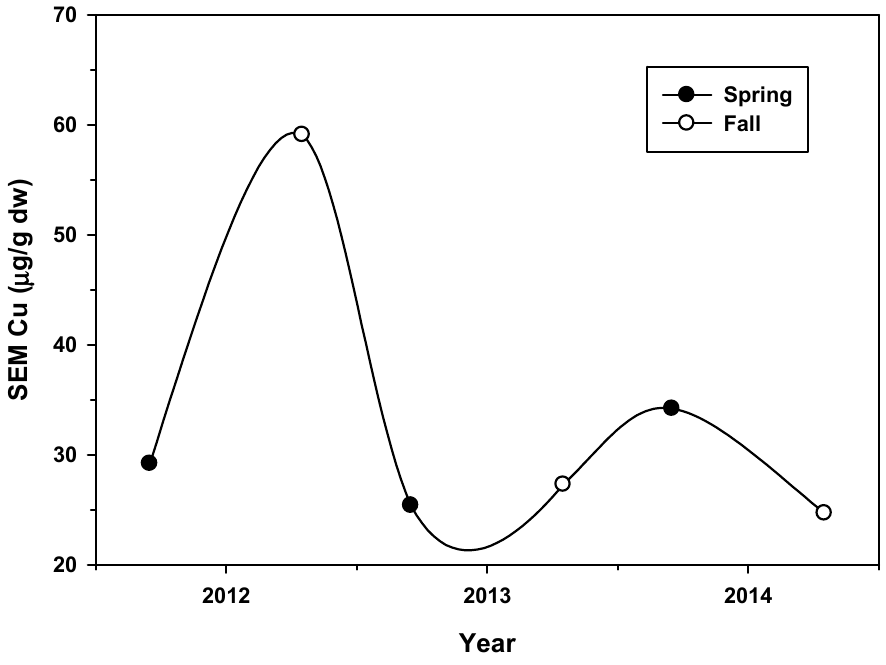
Figure 8. SEM copper concentrations (µg/g dry wt) from spring and fall sediment sampling at Cache Slough site CS-07 for the years 2012, 2013 and 2014.